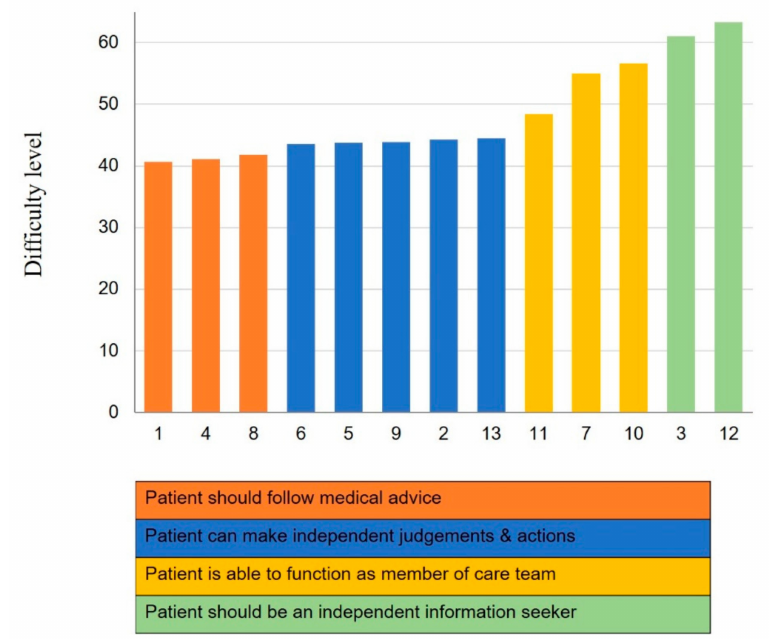
Figure 1. Di ffi culty structure of the Korean